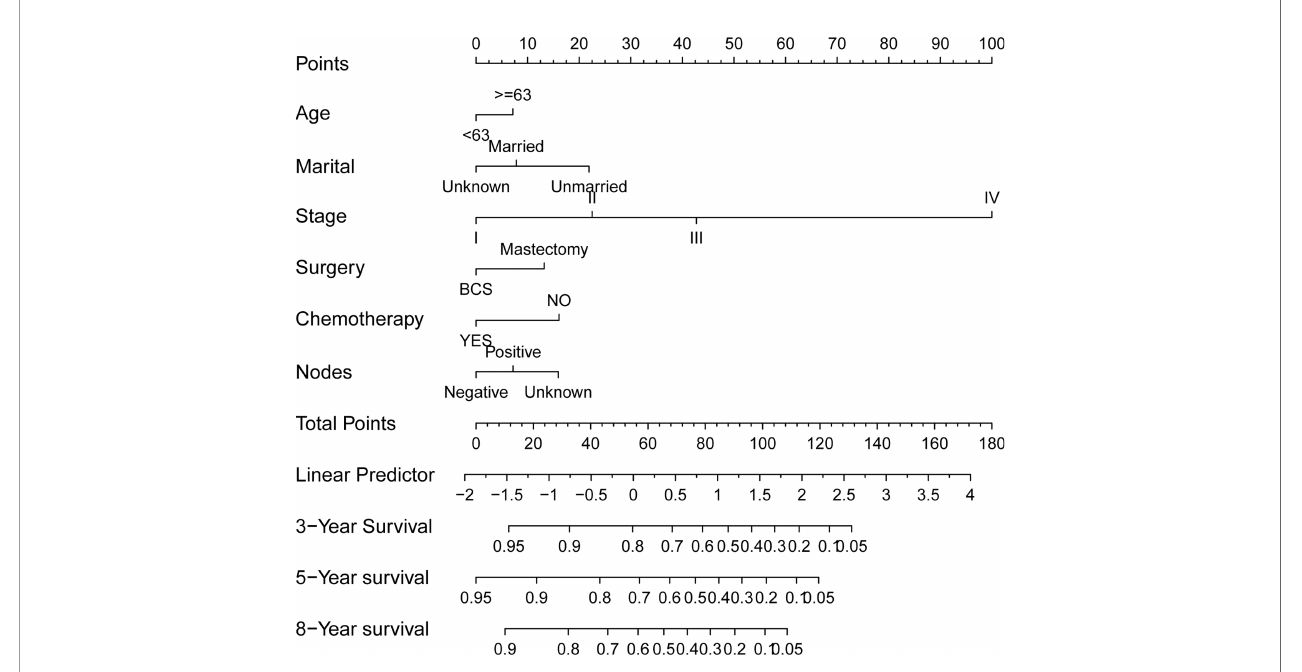
FIGURE 2 | Prognostic nomograms of 3-, 5-, and 8-year OS in TN MpBC